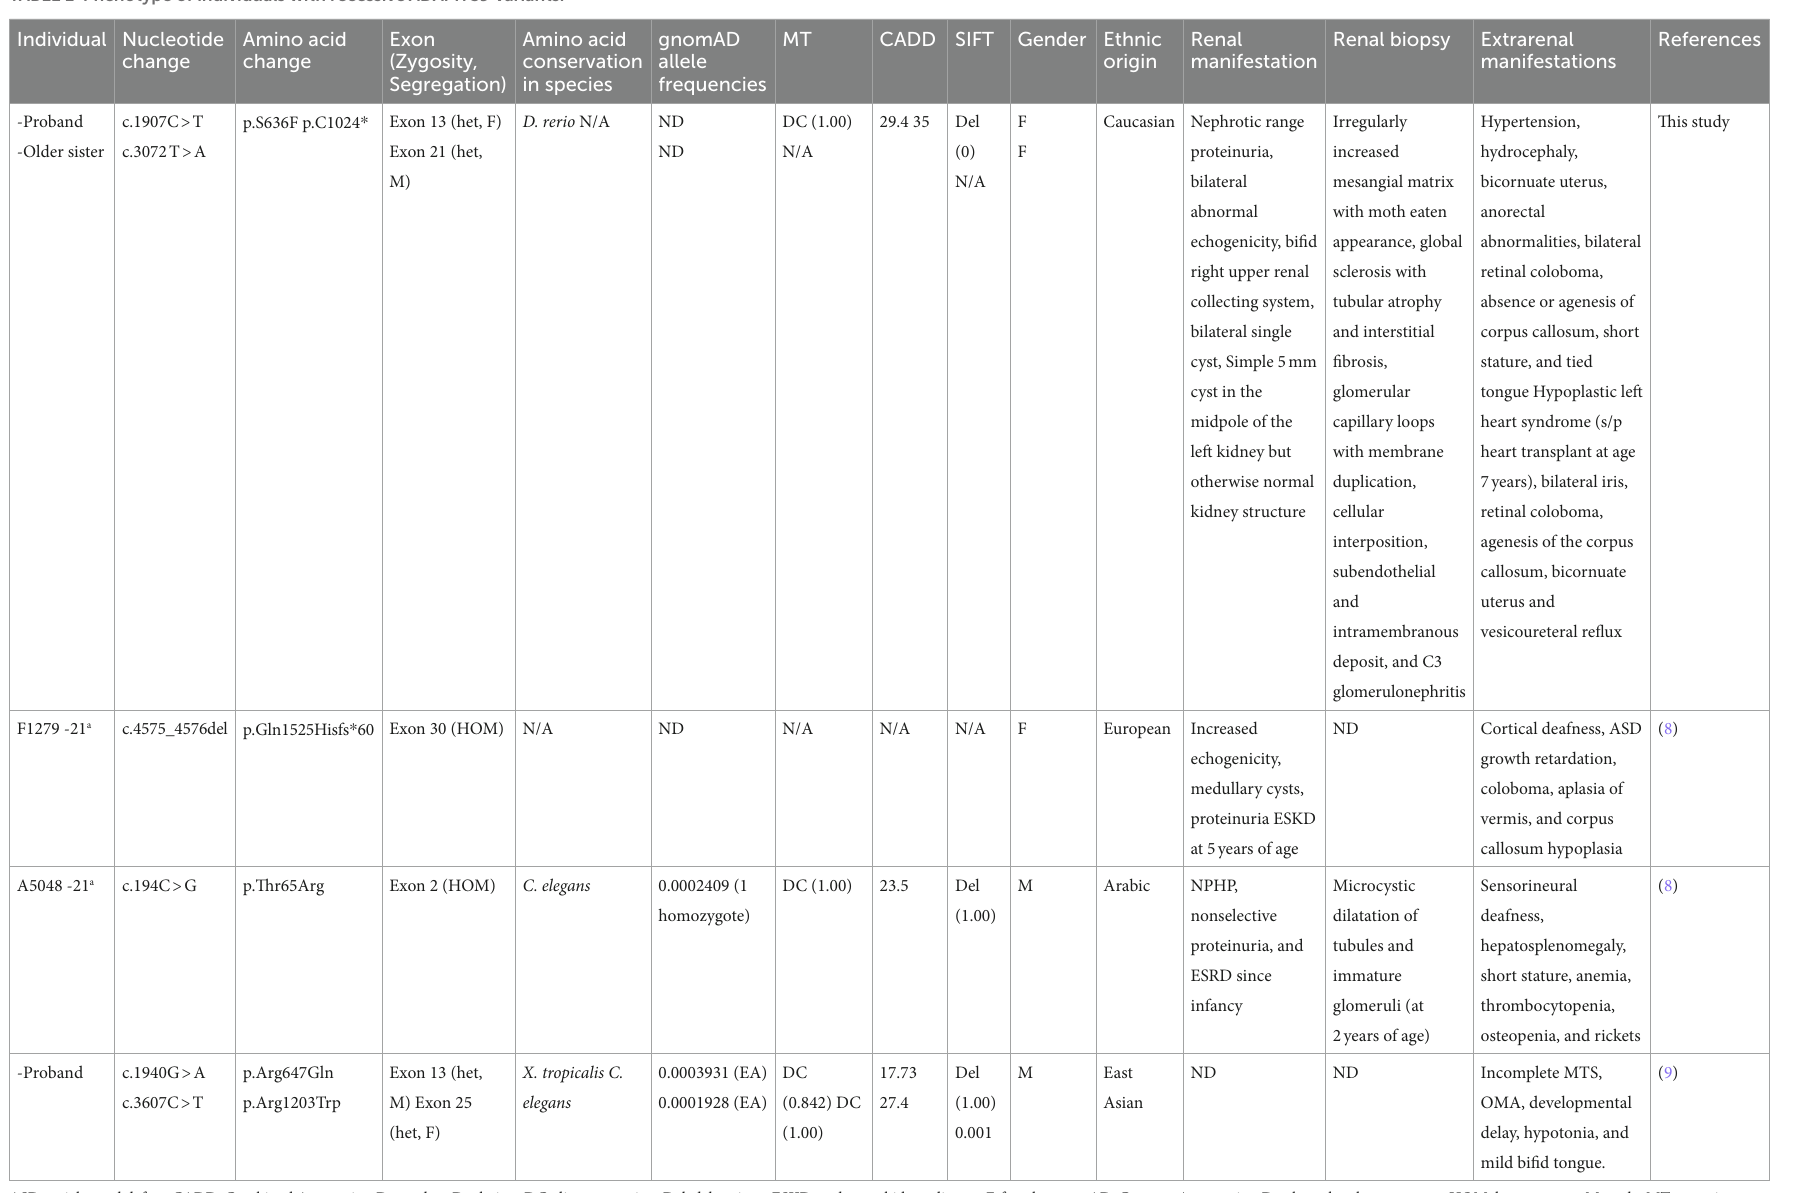
TABLE 1 Phenotype of individuals with recessive ADAMTS9